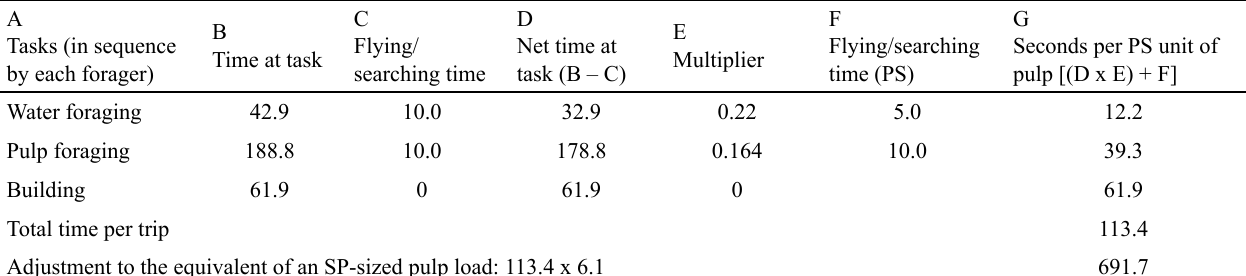
Table 2 . Parallel-series (PS) system. Times required if P. occidentalis were to use the PS system of nest construction. Tasks are performed in sequence by a forager-builder. Time at task (column B) is time off-nest for foragers and time spent building for builders (derived from data for large colonies (Jeanne, 1986, Table 2)). Columns C-F are adjustments made for the PS system. Times in seconds. See text for detailed explanation.